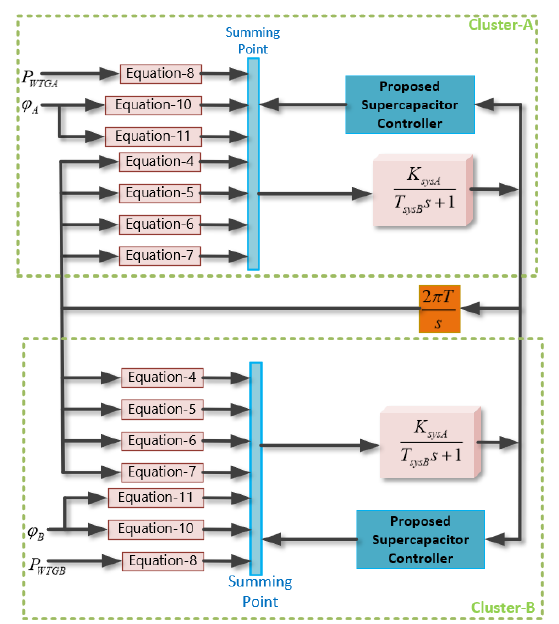
Figure 3. Control diagram for microgrid